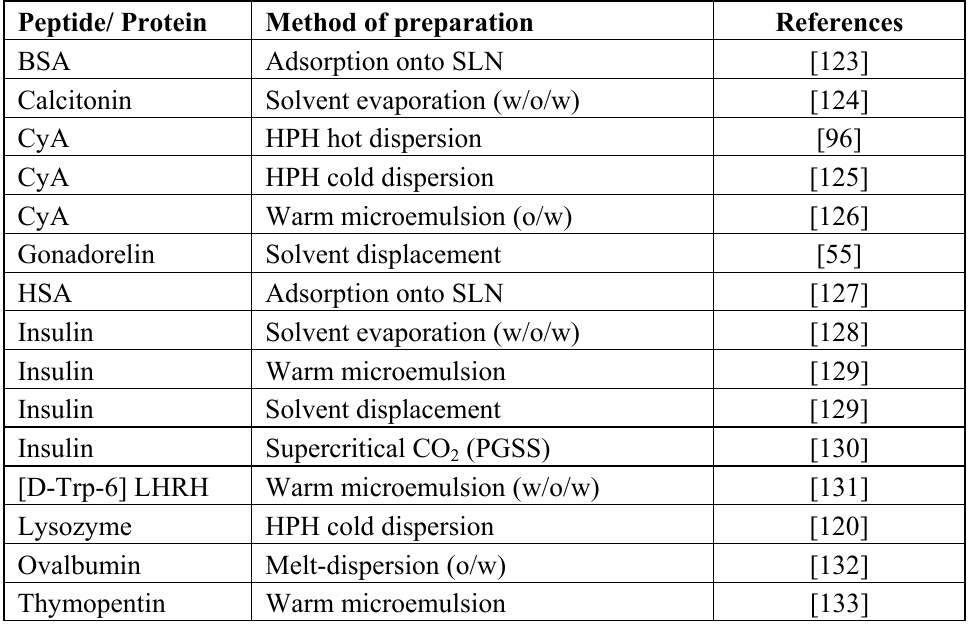
Table 1. Peptide and protein molecules incorporated in solid lipid nanoparticles. Peptide/